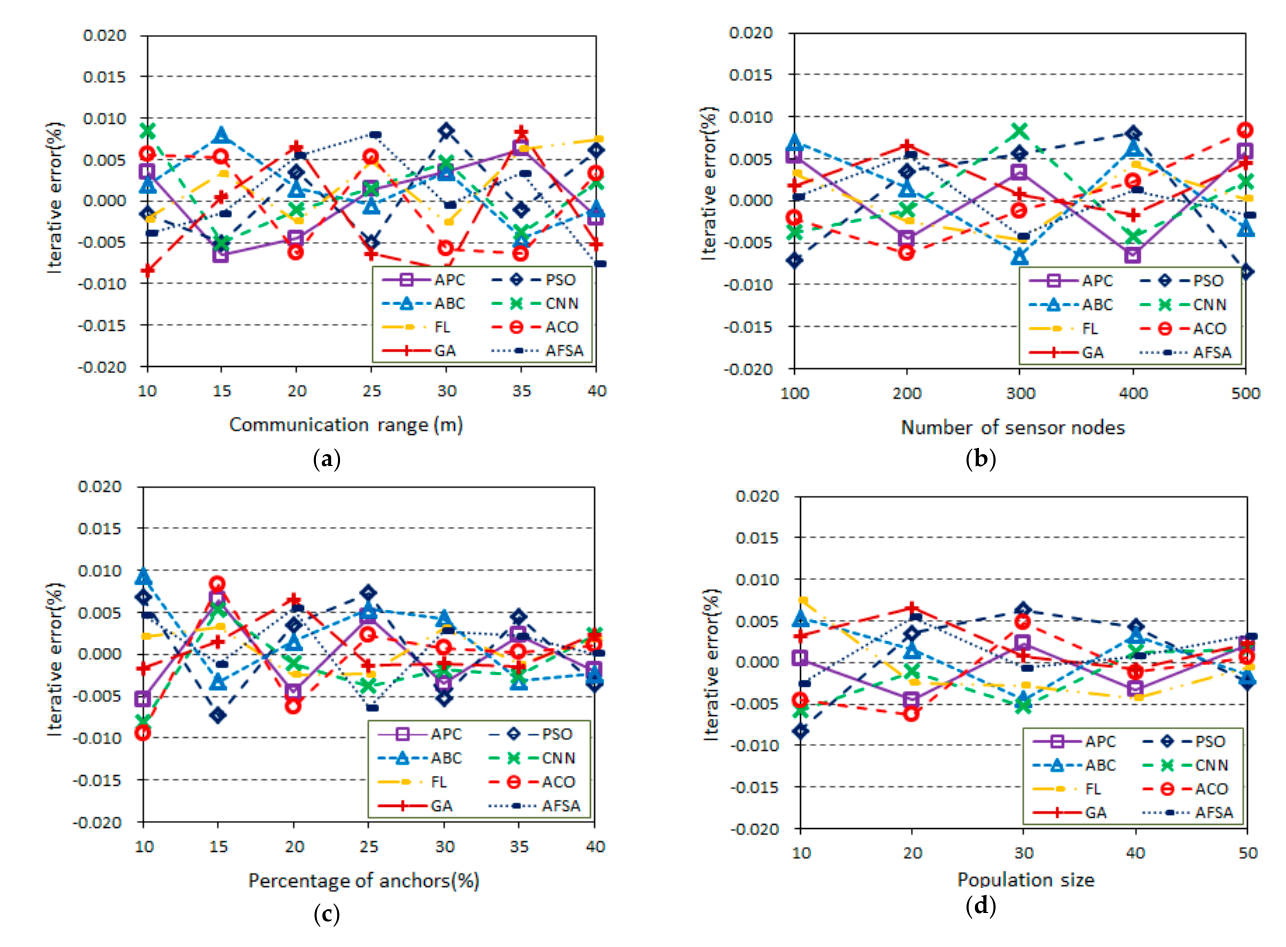
Figure 5. Algorithm comparison in terms of the iterative error. ( a ) Communication range vs. iterative error (200 sensor nodes, 20% anchor nodes, population size m = 20); ( b ) the total number of sensor nodes vs. the iterative error (communication range r = 20 m, 20% anchor nodes, population size m = 20); ( c ) percentage of anchor nodes vs. the iterative error (communication range r = 20 m, 200 sensor nodes, population size m = 20); ( d ) population size vs. the iterative error (communication range r = 20 m, 200 sensor nodes, 20% anchor nodes).